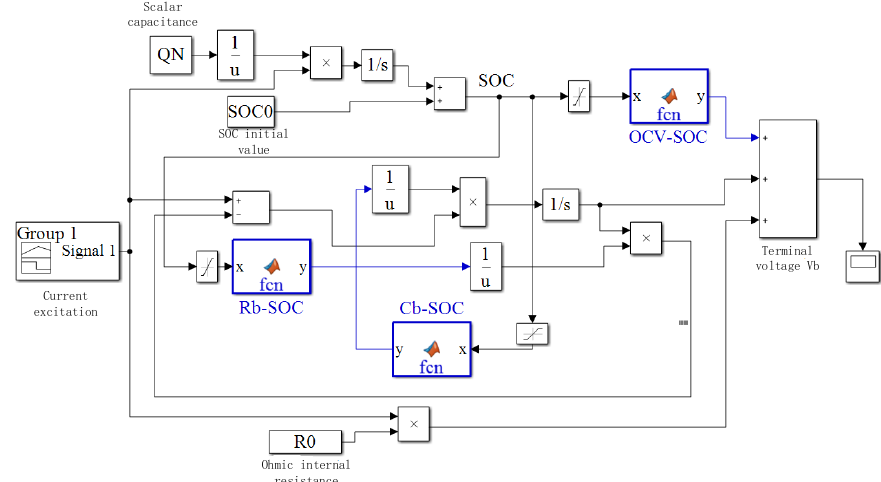
Figure 6. Battery model considering the changes of the internal resistance and the capacitance with different SOC .